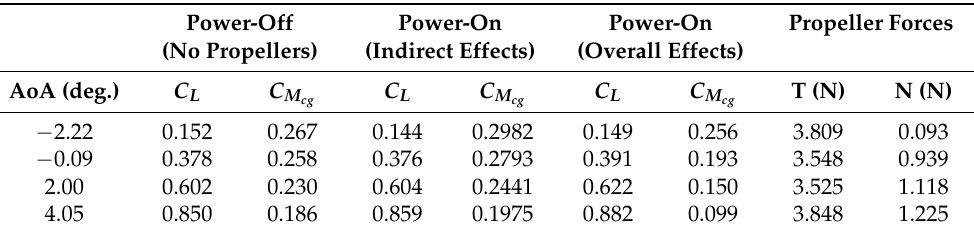
Table 11. Direct and indirect propeller effects breakdown, on the complete aircraft configuration, Re = 315,000, X CG at LE MAC, 8750 RPM (CR). Power-Off Power-On Power-On Propeller Forces (No Propellers) (Indirect Effects) (Overall